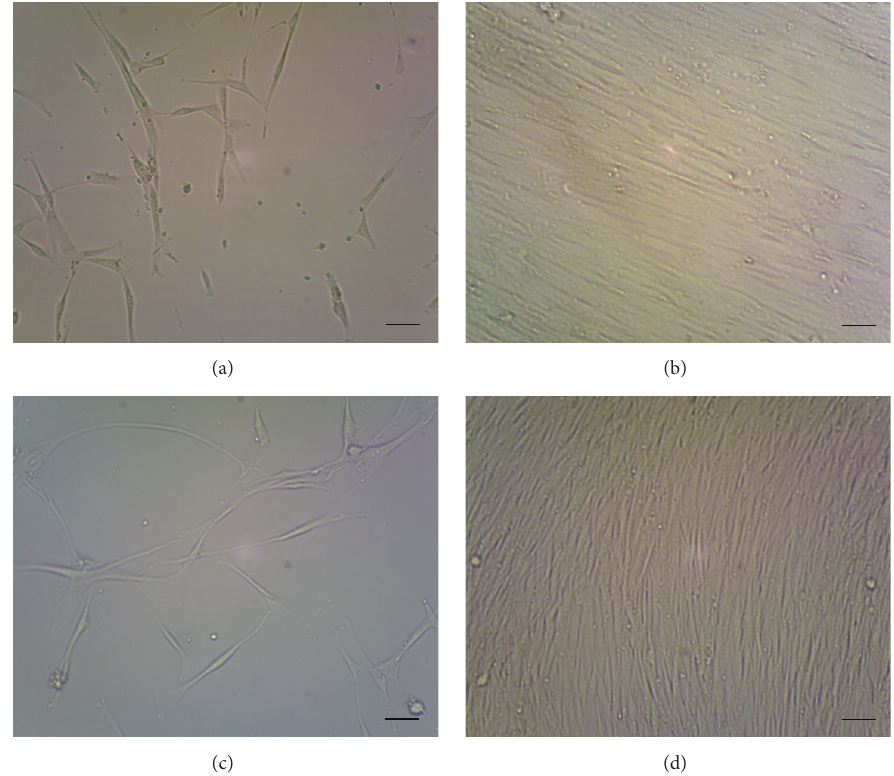
Figure 1: Morphological characteristics of bone marrow mesenchymal stem cells (BMMSCs) and skin mesenchymal stem cells (SMSCs). (a) BMMSCs cultured for 7 days. (b) BMMSCs cultured for 16 days. (c) SMSCs cultured for 16 days. (d) SMSCs cultured for 29 days. Scale bar: 10 𝜇 m.